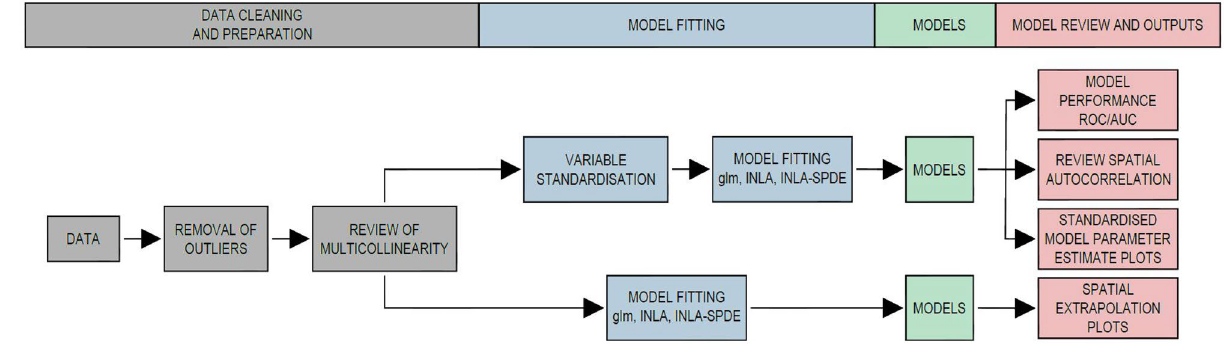
Figure 5. Schematic flowchart of the overall spatial modelling approaches